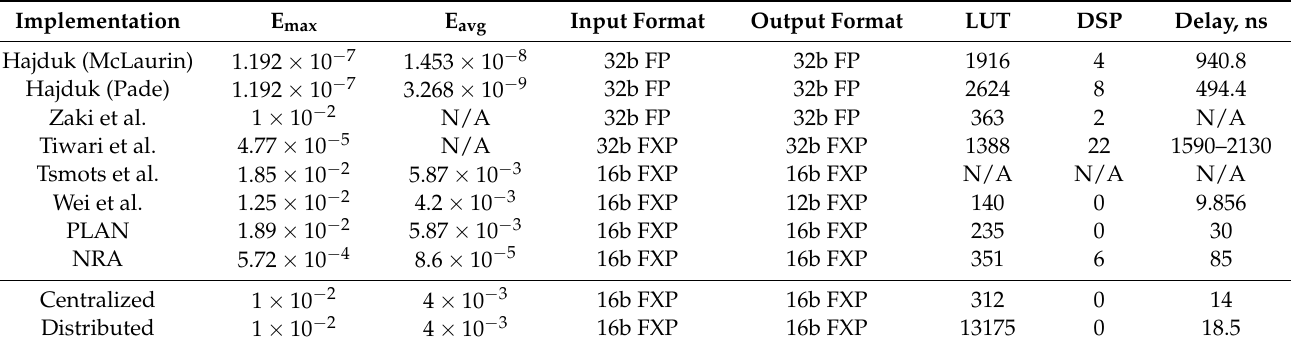
Table 3. Comparison of the developed models and alternative